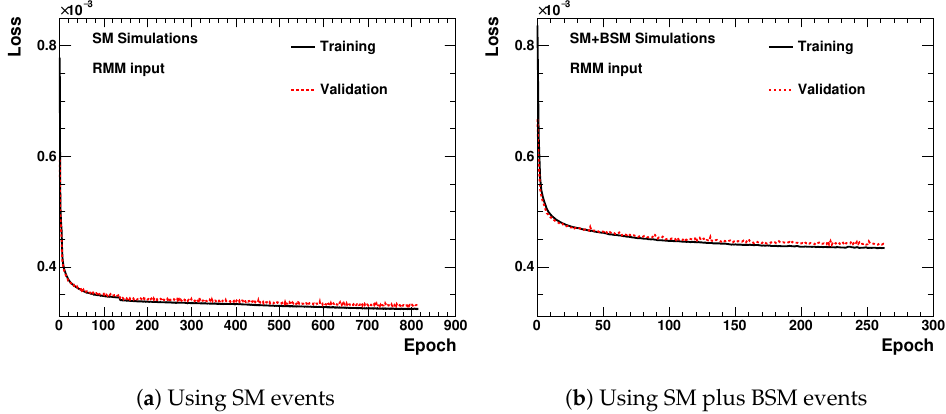
Figure 1. Loss as a function of epochs using the RMM inputs when using ( a ) only SM events; ( b ) using SM events plus 1000 BSM events described in the